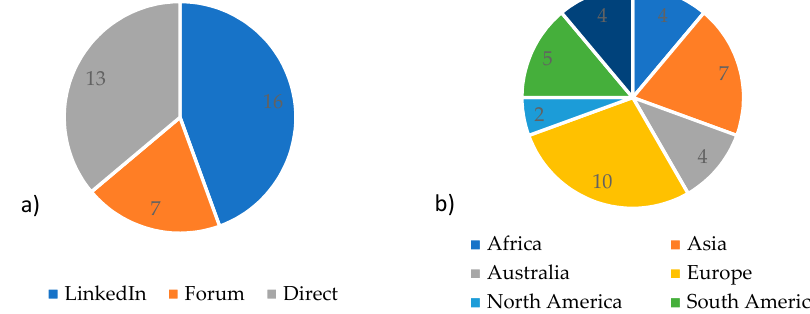
Figure 1. Origin of survey respondents: ( a ) survey distribution method ( b ) region.